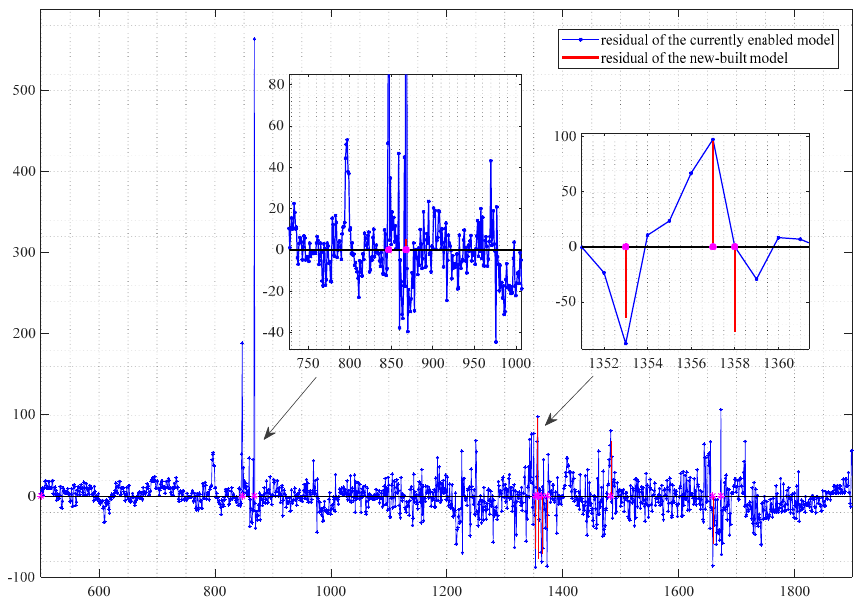
Figure 9. Model residuals of the online learning-based fault detection method during sea trial of the HOV.